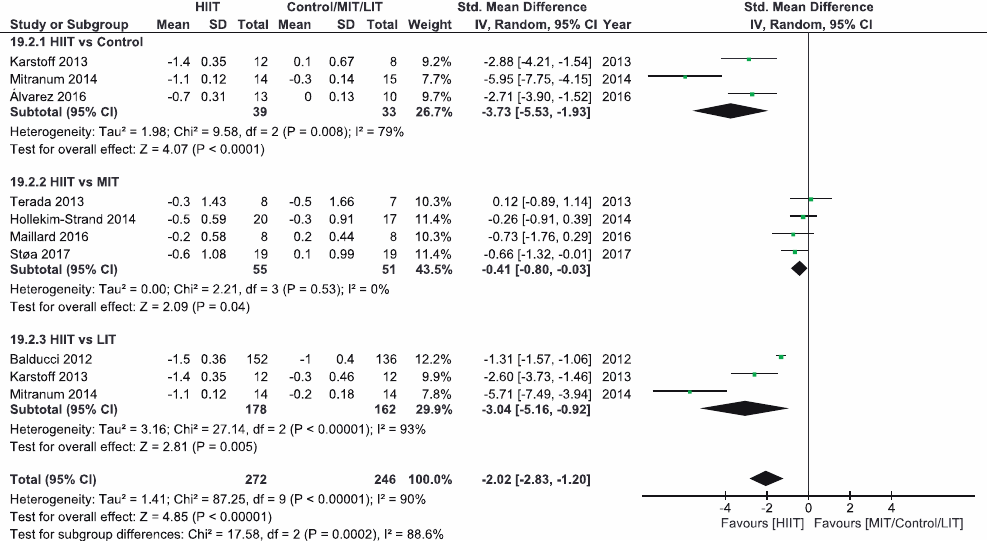
Figure 3. Forest plot for BMI. HIIT—high-intensity interval training, MIT—moderate-intensity training, LIT—low-intensity training, CI—confidence interval, IV—inverse variance, SD—standard deviation.